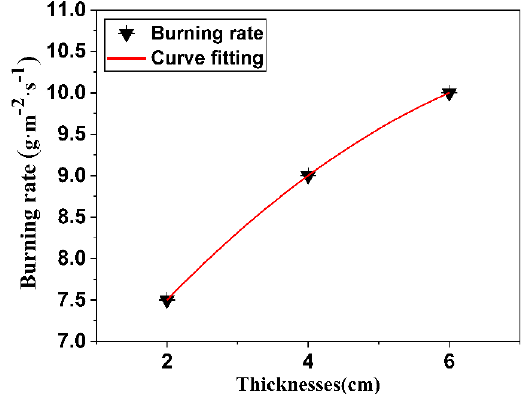
Figure 4. The burning rate fitting curve with different thicknesses.